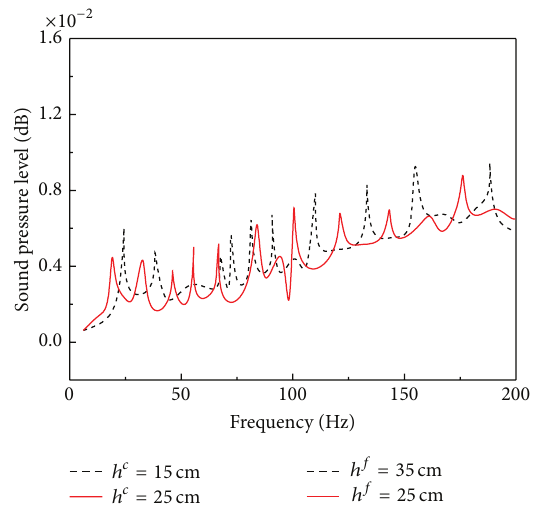
Figure 14: Acoustic pressure of the underwater structure with different thickness of FGM core and viscoelastic coating.